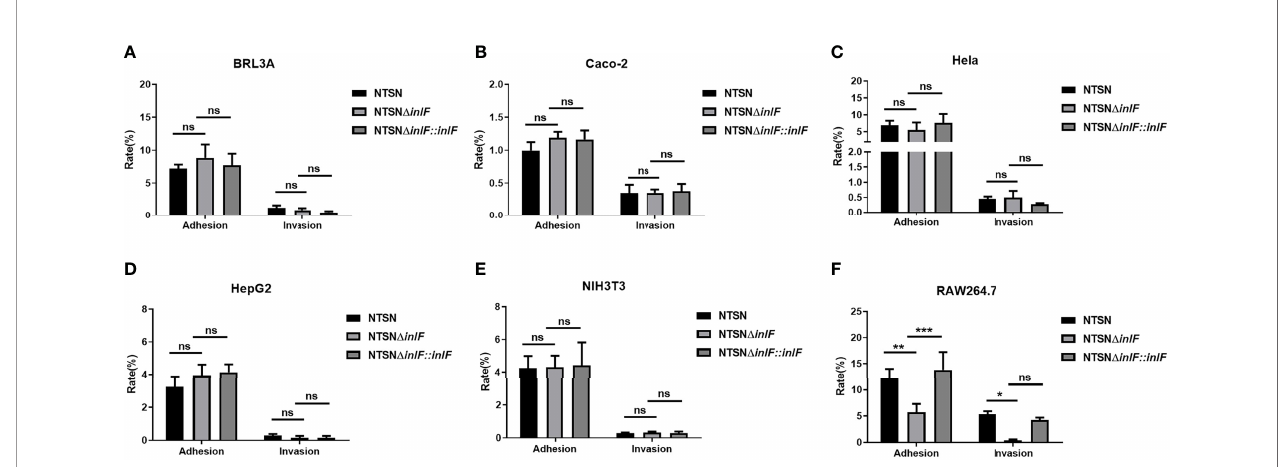
FIGURE 2 | Comparative invasive capacities of Lm NTSN NTSN D inlF and NTSN D inlF::inlF . Six types of cells ( Supplementary Table 1 ) were infected (MOI = 20) with Lm NTSN, NTSN D inlF , and NTSN D inlF::inlF , respectively. The percentage of intracellular bacterium was calculated after 1h of bacteria invasion. Shows are the adhesion and invasion of Lm to 5 types of non-phagocytes (A – E) , to macrophage RAW264.7 is shown in (F) . Among them, the PBS negative control group is represented by horizontal line bar, NTSN is represented by black and white check bar and the mutant is represented by black dot bar. Error bars represented SEM, n = 3 independent experiments. Statistical analysis was carried out by Tukey ’ s multiple comparisons test: *P < 0.05, **P < 0.01, ***P < 0.001, ns, no signi fi